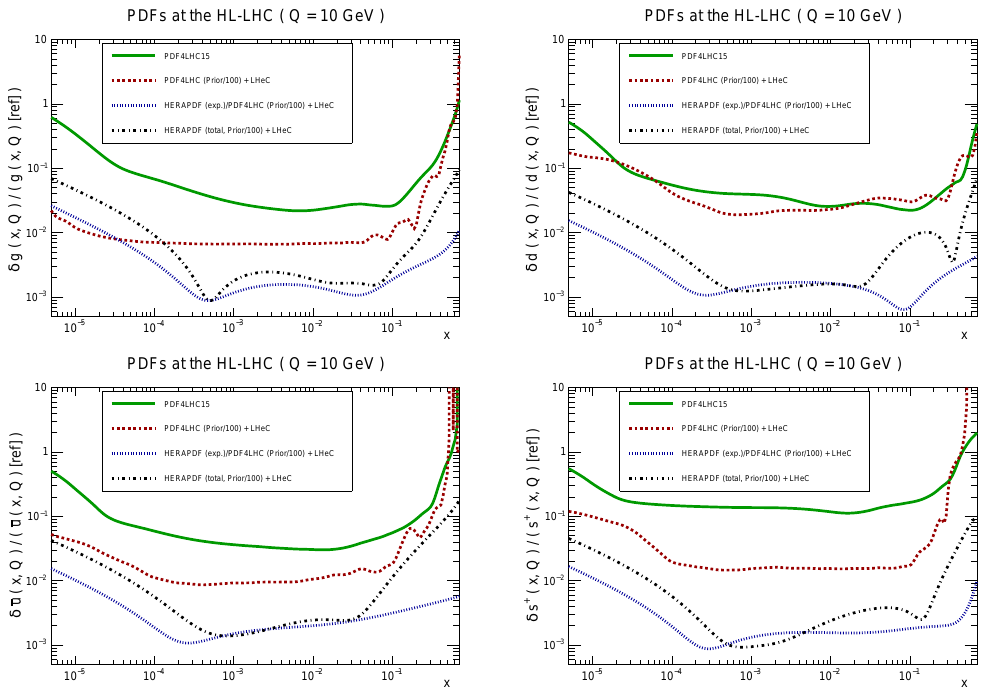
Figure 5.6: As in Fig. 5.5 but with the relative errors